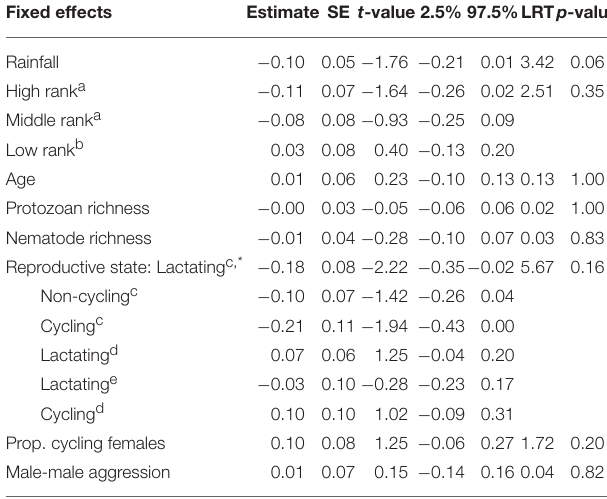
TABLE 2 | Estimates, standard errors (SE) and confidence intervals of fixed effects predicting variations in fecal neopterin concentrations in sexually mature females ( N = 32 individuals and 149 samples; mean number of samples per female ± SD: 4.7 ± 4.5; range: